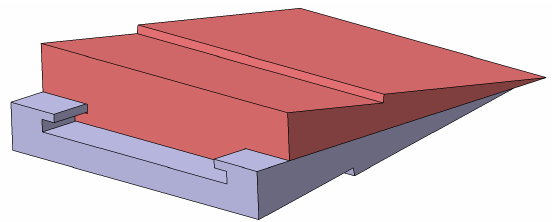
Figure 3. Trailing edge slider.